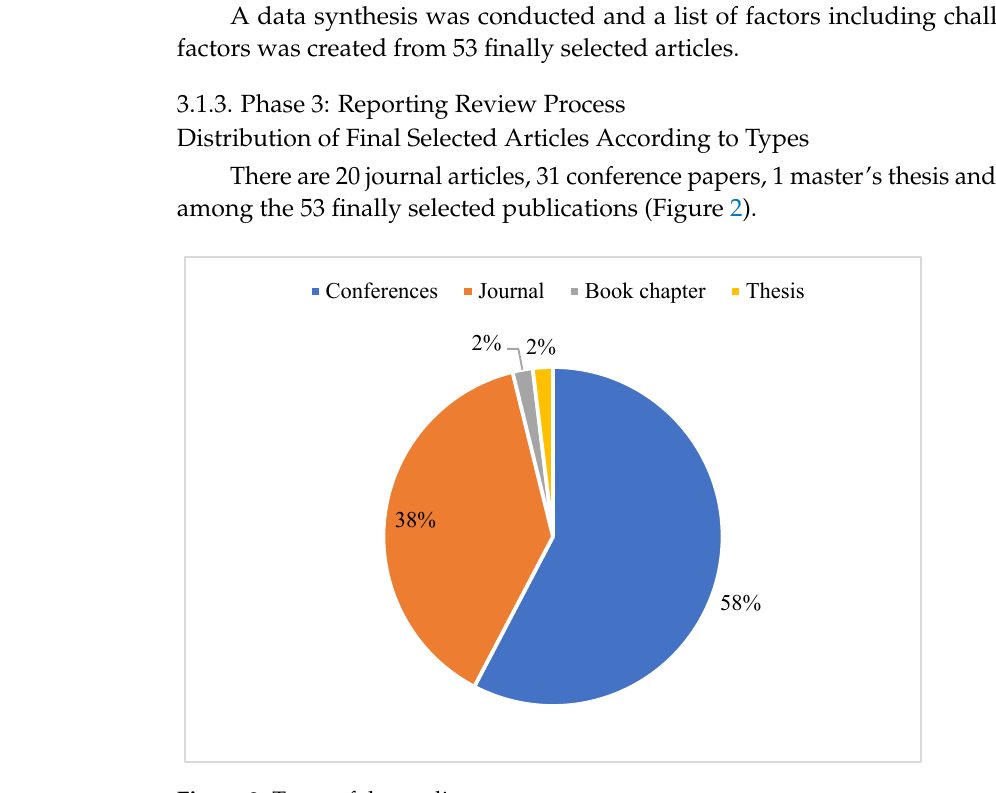
Figure 2. Types of the studies.